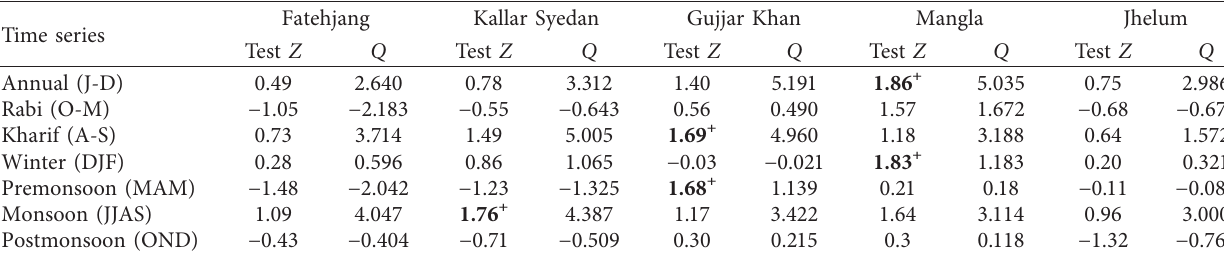
Postmonsoon (OND)